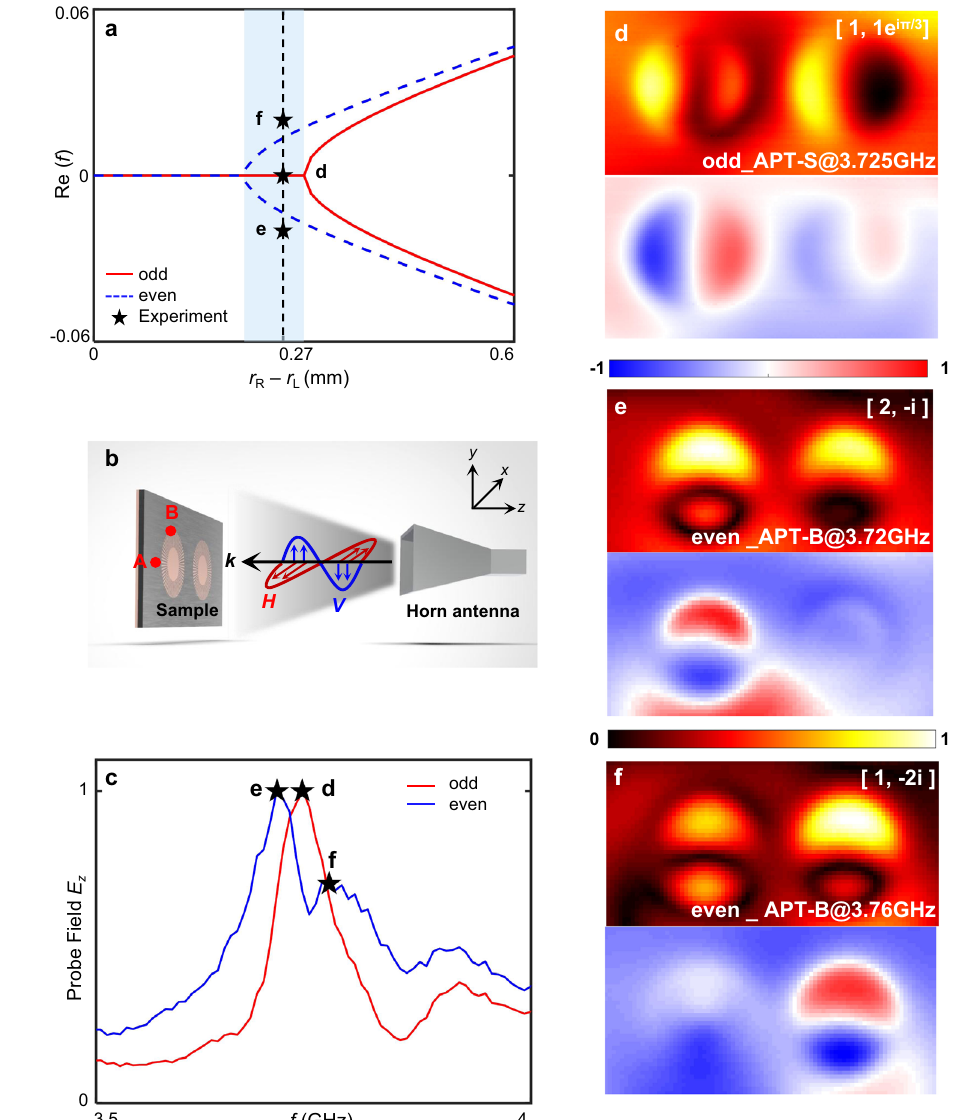
Fig. 4 | The polarization-controlled APT phase transition. a The evolution of eigen frequencies as the detuning r R − r L changes for odd (red) and even (blue) modes. The stars mark the detected resonance frequencies on the sample r − r fi eld excitation setup. The red and blue arrows denote R L =0.27mm. b The far- horizontally(H)andvertically(V)polarizedspacewaves,respectively.PointsAand B denote the probe positions for odd and even modes respectively. c The